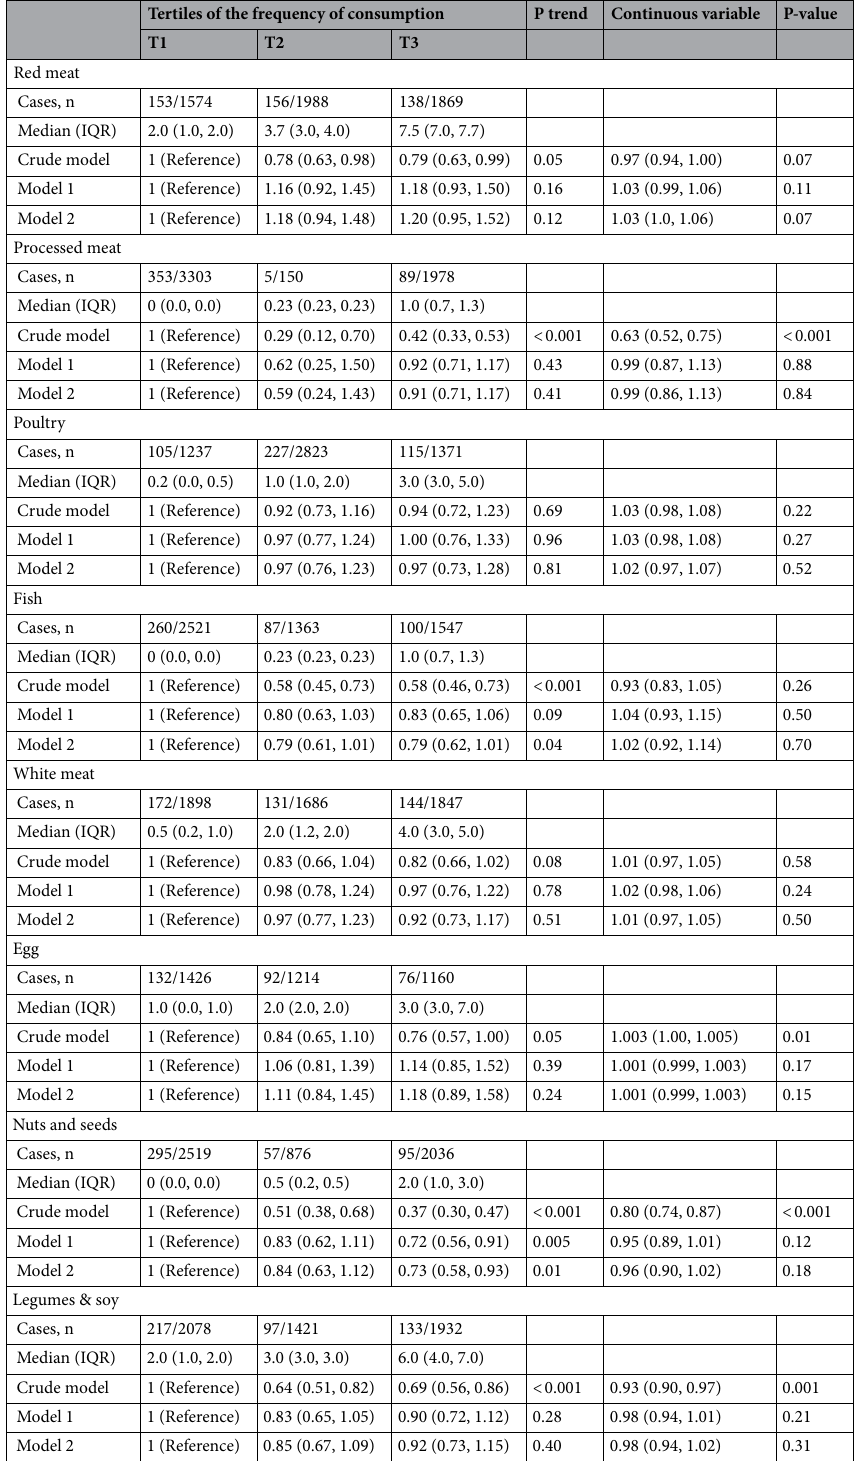
Table 4. Multivariate-adjusted HRs (95% CIs) of death according to tertiles of specific major proteins sources in the ICS. Model 1: HRs are adjusted for age (continuous), sex, education, smoking status, physical activity, body mass index and fruit and vegetables. Model 2: Additionally adjusted for hypertension, diabetes mellitus and